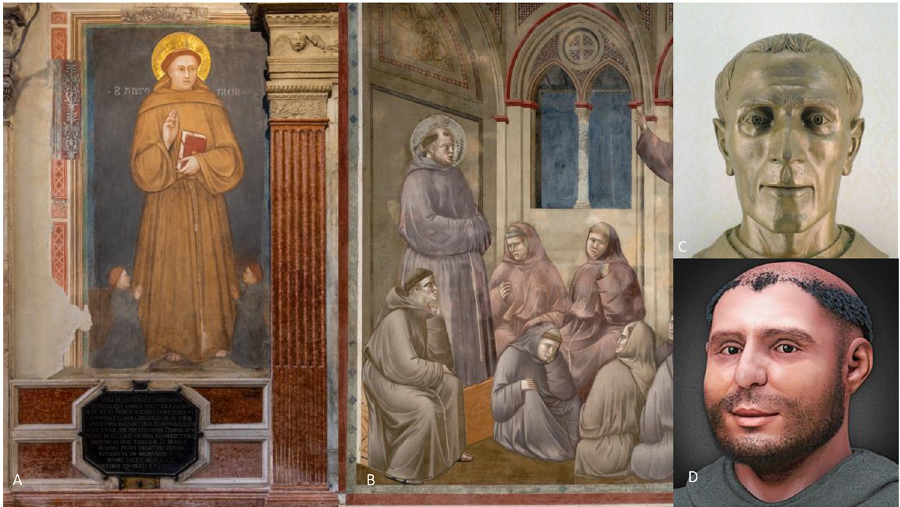
Fig 1. The representation of St Anthony. (A) St Anthony giving his blessing, Giotto School. This portrait is considered to reflect the true effigy of the Saint. Padova, Basilica del Santo (1238–1310), Giovanni Pinton/ Archivio Fotografico Messaggero di Sant’Antonio, 2020. (B) Giotto, St Francis appears in the Chapter of Arles, ca. 1295– 1299. Assisi, Chiesa Superiore of Basilica di San Francesco. In the detail, St Anthony is illustrated suffering, with a bloated abdomen. (C) Bust of St Anthony, detail. Bronze sculpture by Roberto Cremesini, 1995. This is a scientific reconstruction of the ’real’ face of the Saint, based on the skull found after the recognition of his body in 1981. In the reproduction of this bust, the artist relied on the advice of three scholars: C. Corrain (anthropologist), V. Meneghelli (anatomist) and V. Terribile Wiel Marin (anatomopathologist). Photo by Giorgio Deganello/ Archivio Fotografico Messaggero di Sant’Antonio, 1995. (D) The 3D Forensic Facial Reconstruction of St Anthony of Padua. Cicero Moraes—Opera propria, CC BY 3.0,